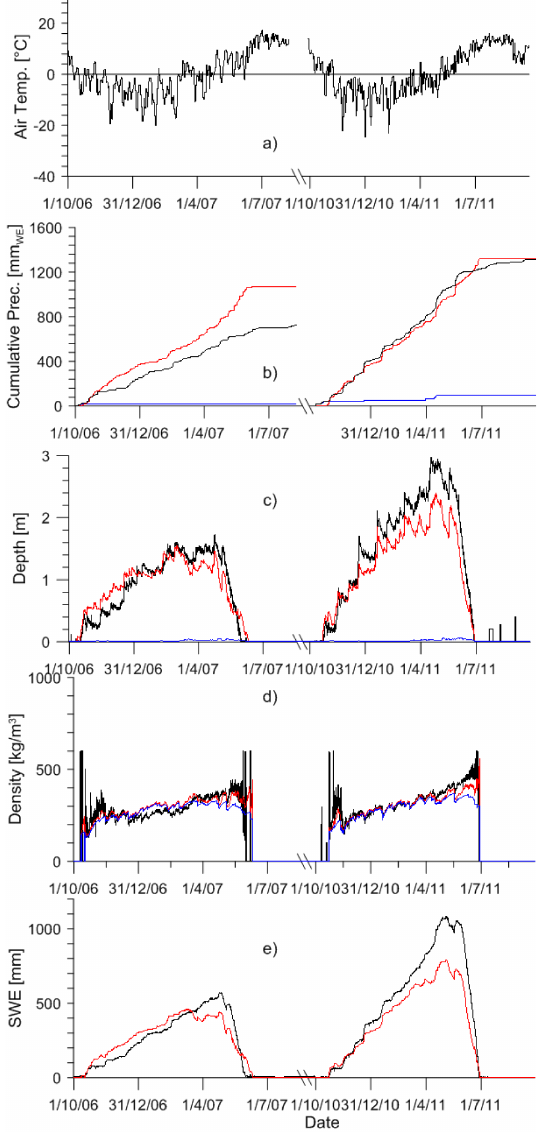
Fig. 3. Meteorological forcings, and dynamics of depth, density and SWE for S2 and two hydrologic years: 2006–2007 (calibration) and 2010–2011 (validation). (a) Air temperature, (b) cumulative pre- cipitation, total observed in black, liquid modeled in blue and solid modeled in red, (c) depth h in red modeled and in black observed, and h W in blue, (d) density ρ in red modeled and in black observed and ρ D in blue, and (e) SWE in red modeled and in black observed.